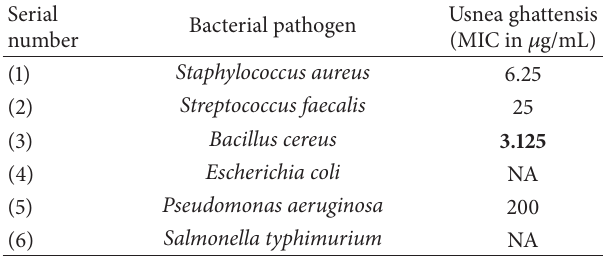
Table 2: Results of Minimum Inhibitory Concentration (MIC) of extracts of Usnea ghattensis against tested